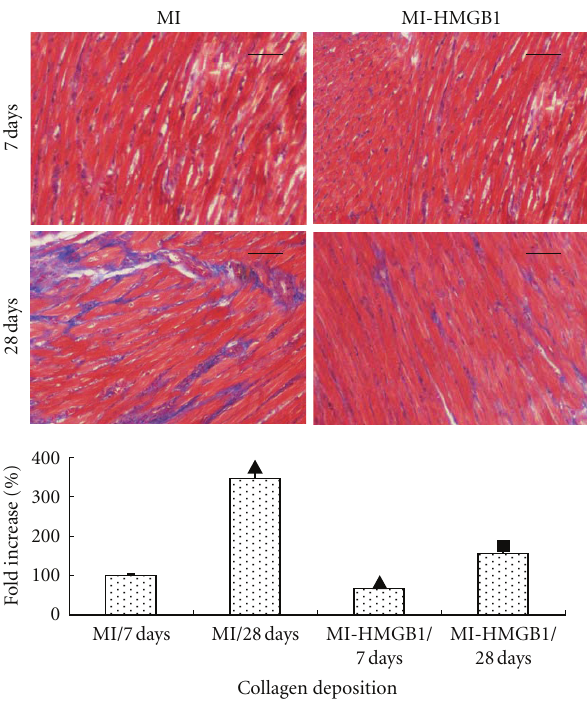
Figure 3: Representative Masson trichrome-stained sections (blue) of hearts after MI ( n = 5 for each group). (cid:2) P < 0 . 05 versus MI/7 days; (cid:3) P < 0 . 05 versus MI/28 days. Abbreviations are identical